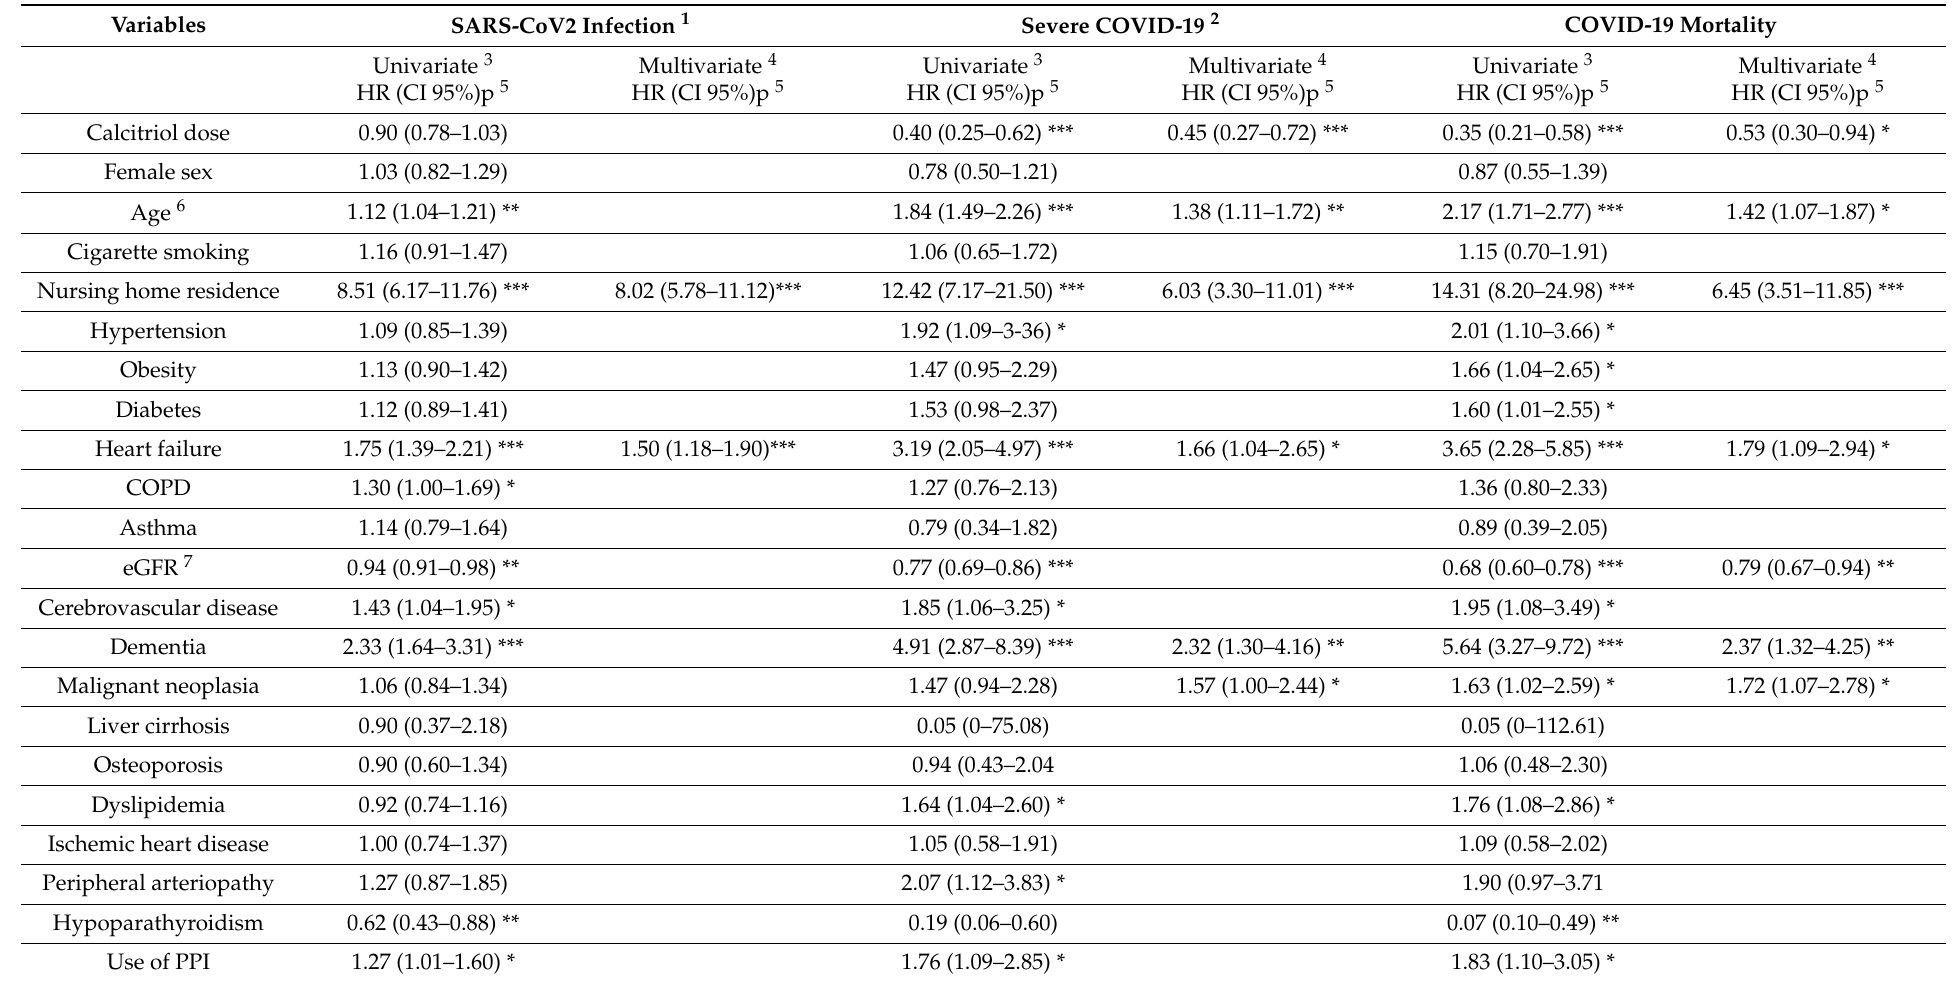
Table 3. Associations between mean daily calcitriol dose and COVID-19 outcomes ( n =